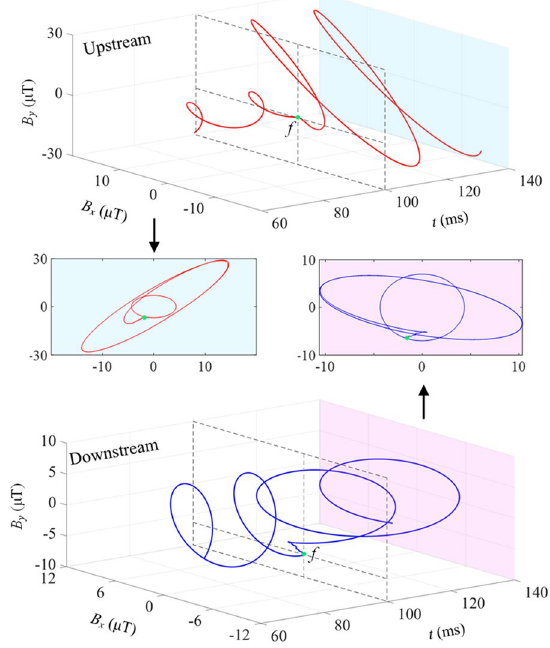
Fig. 3 Dynamic trajectory of magnetic field upstream and downstream of fault point